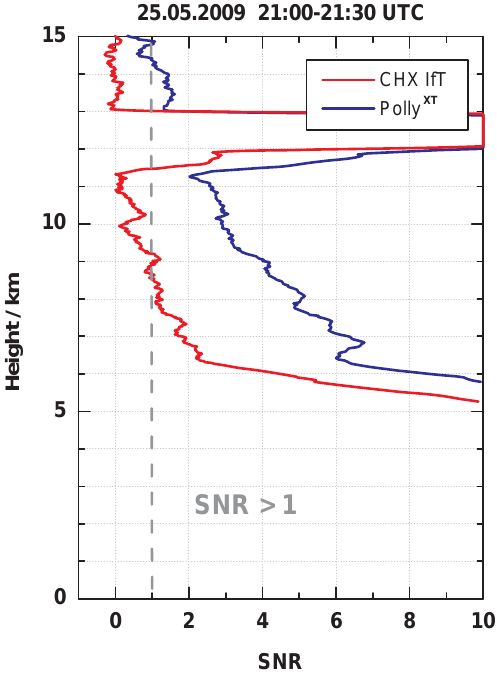
Fig. 4. SNR of 30min mean CHM ceilometer and lidar signals on 1 May 2009 during daytime.